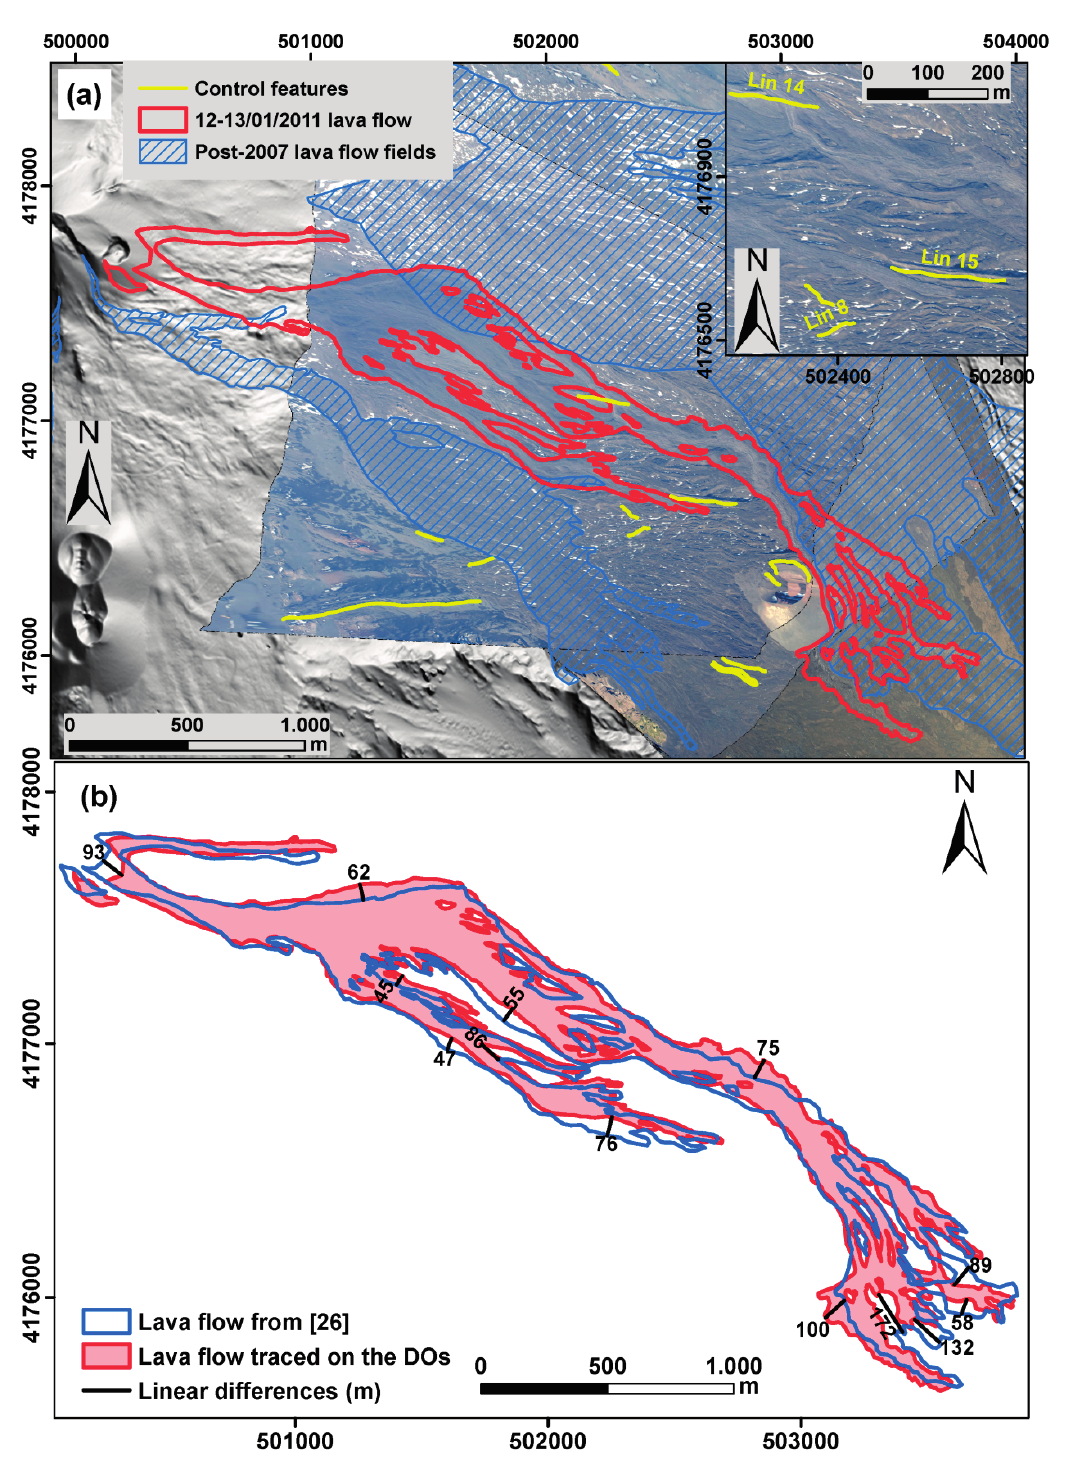
Figure 11. Test 5—2011 lava flow in Valle del Bove (Mount Etna): ( a ) Limits of the 12–13 January 2011 lava flow (red line) drawn on the 19 January 2011 DOs, and areas not up-to-date in the 2007 reference DEM ( i.e. , 2007–2010 lava flows, dashed polygons). Yellow lines indicate the morphological features used for accuracy evaluation; the inset shows a detail of some features ( b ) Comparison between the lava-flow field traced on the DOs (red) and that one drawn from direct field observations and photo interpretation (blue line, from